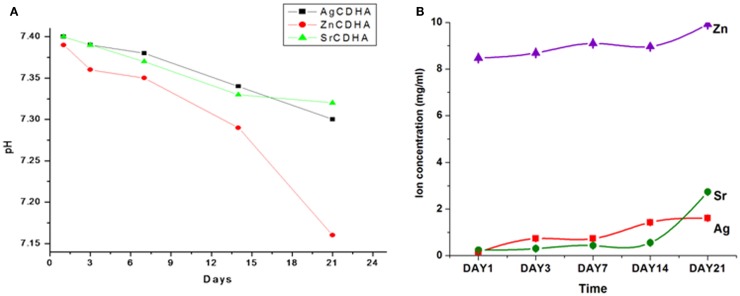
In vitro solubility studies showing pH fluctuations in PBS of pH 7.4 at 37°C (n = 3; data shown as mean; p < 0.005; one-way ANOVA) (A). In vitro dissolution studies of CDHA samples showing ion release in PBS of pH 7.4 at 37°C (n = 3; data shown as mean; p < 0.005, one-way ANOVA) (B).